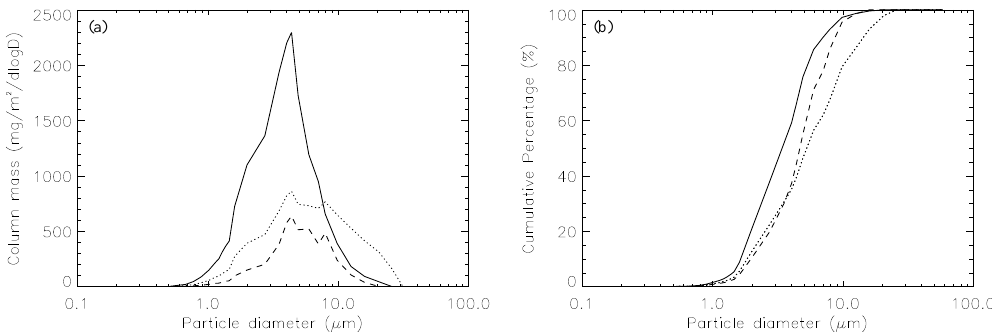
Fig. 2. (a) Observed column-integrated mass and (b) observed column-integrated particle size distribution. 12:00UTC on 5 May (dashed), 13:00UTC on 14 May (dotted) and 15:00UTC on 17 May (solid). Fig. 2. (a) Observed column integrated mass and (b) Observed column integrated particle size distribution. 12 UTC on 5th May (dashed), 13 UTC on 14th May (dotted) and 15 UTC on 17th May (solid).